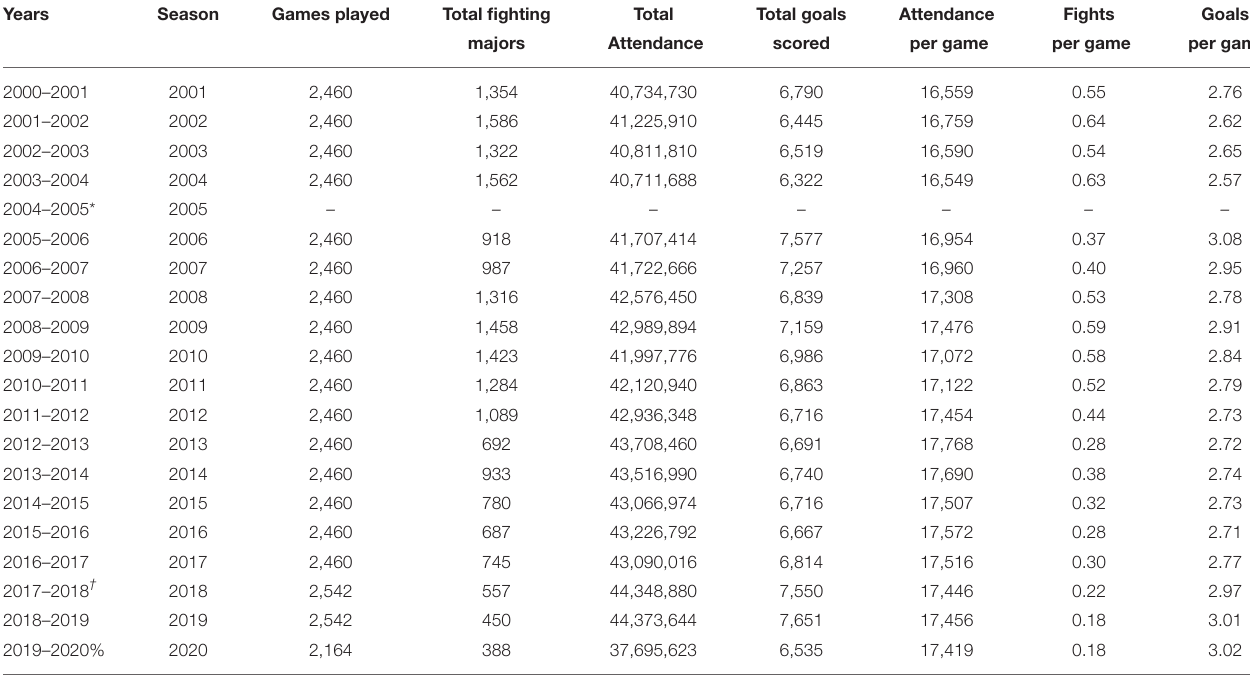
TABLE 1 | Games played, fighting majors, fan attendance, and goals scored during 2000–2020 NHL